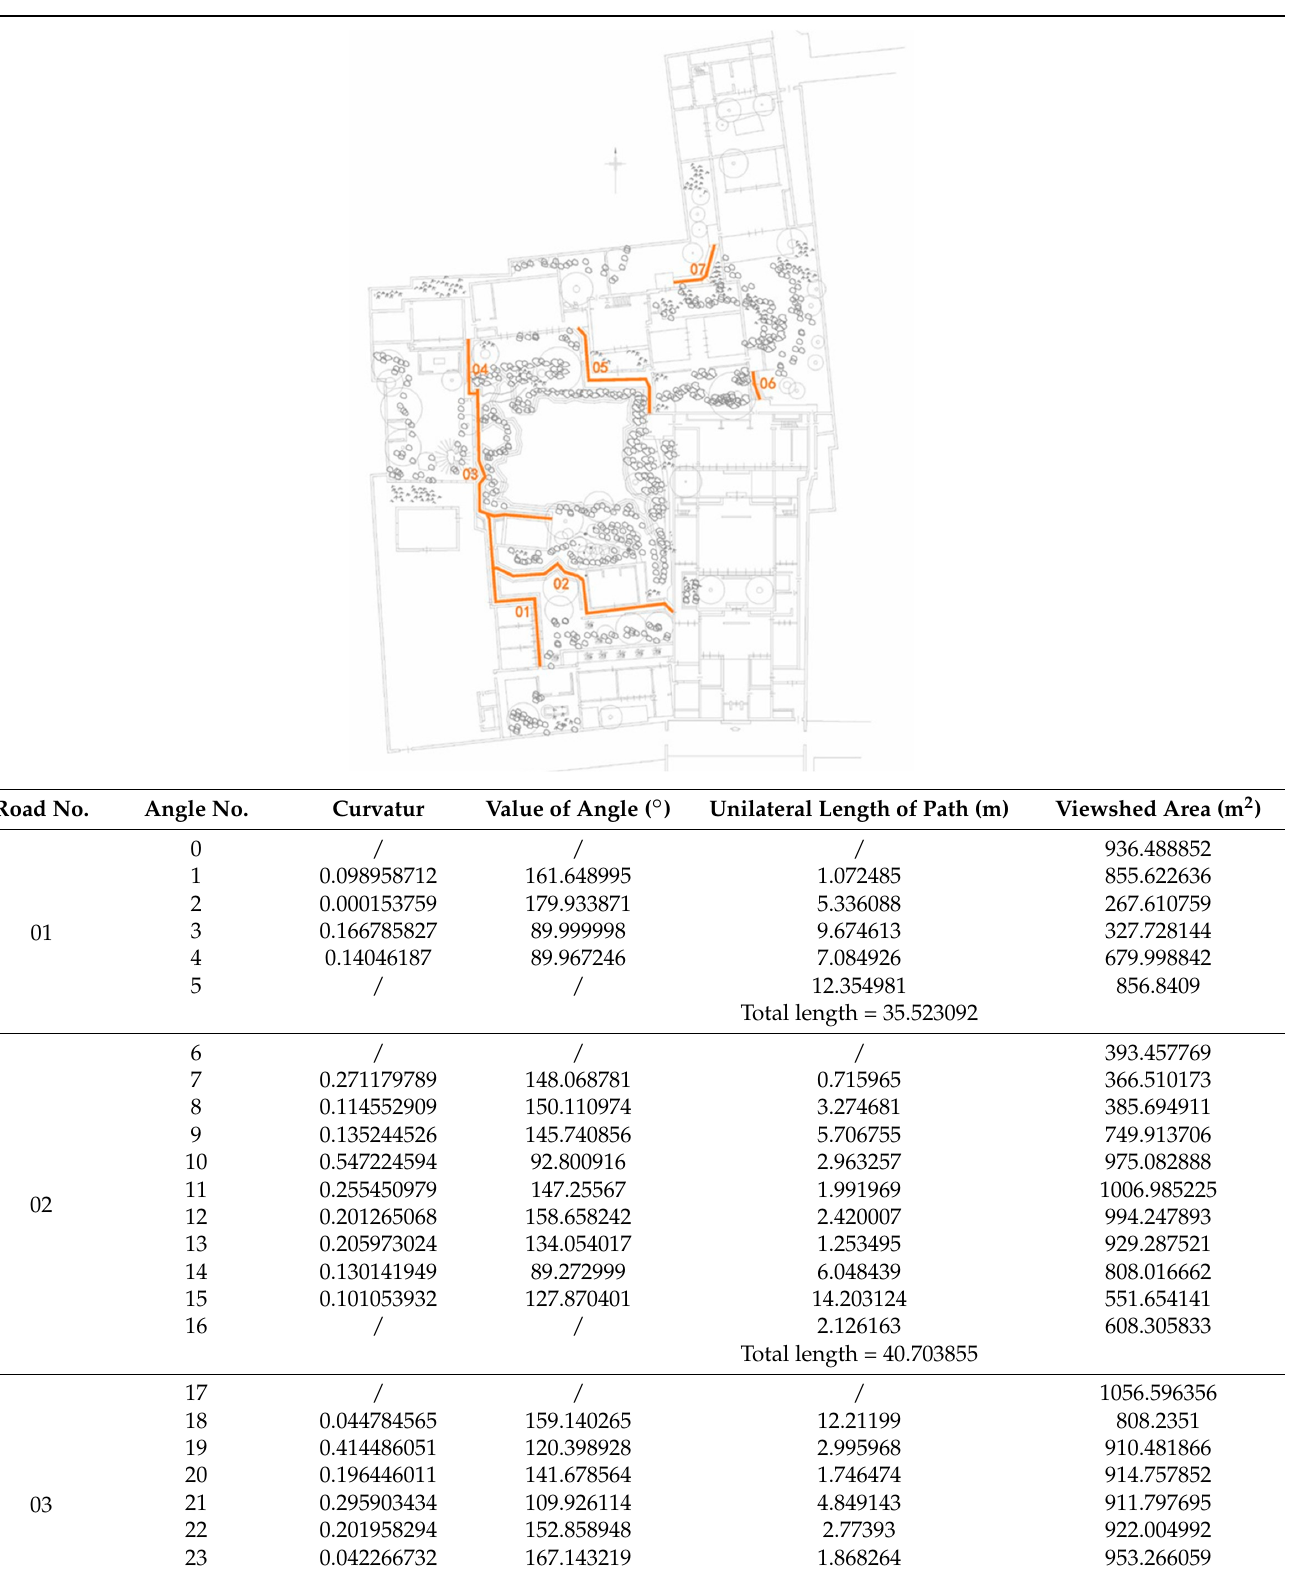
Table A14. Master of the Nets Garden, corridor.